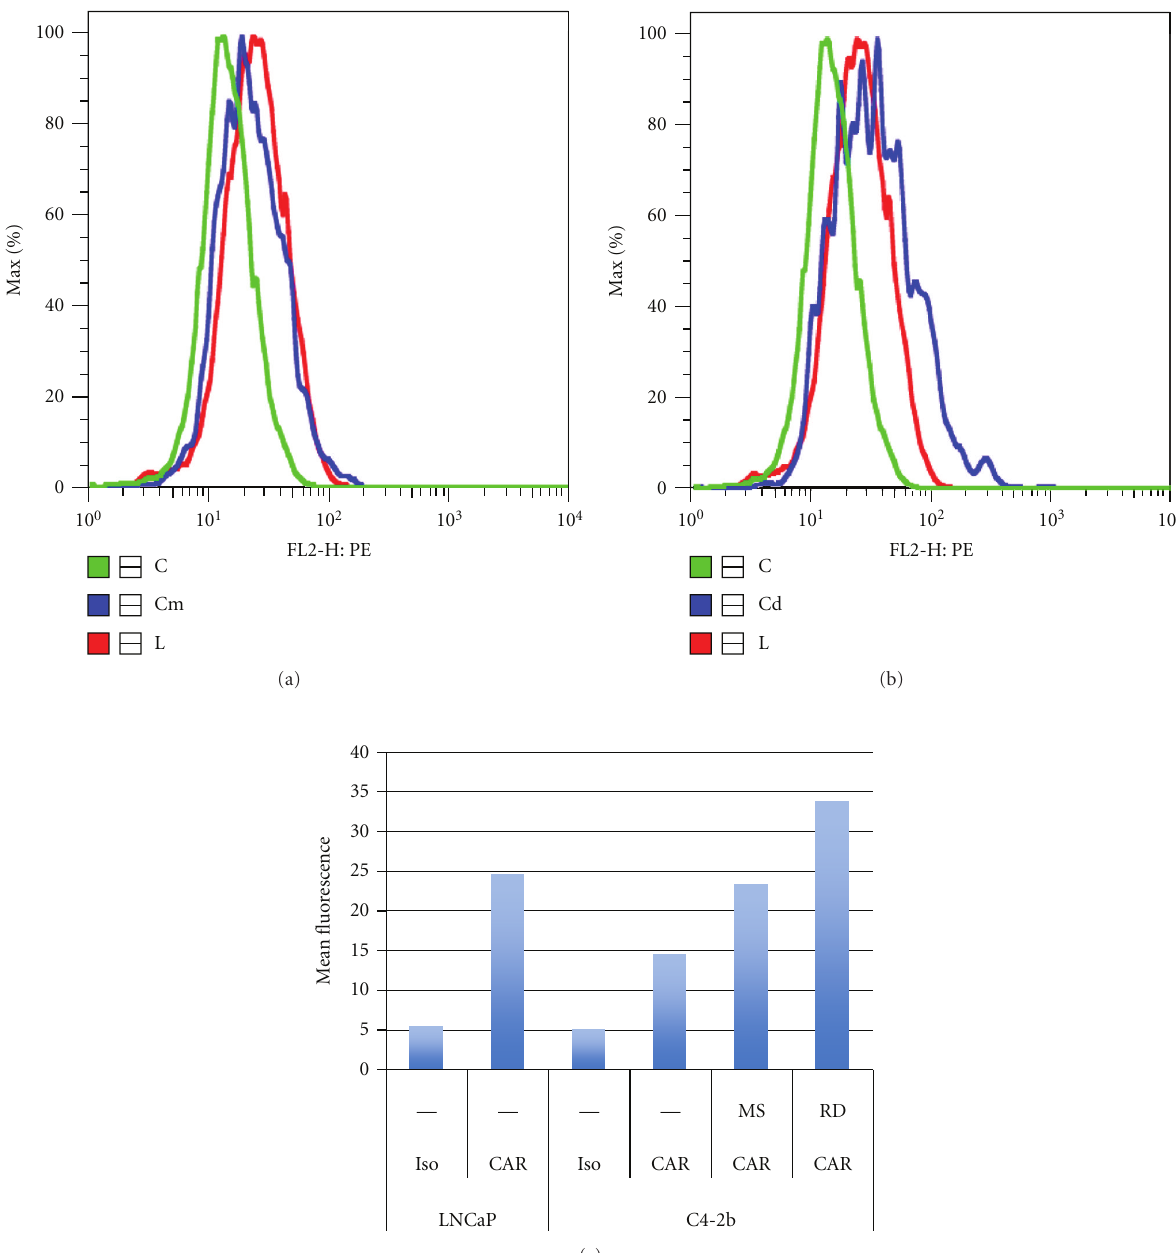
Figure 3: The e ff ect of HDACi on surface CAR expression in C4-2b cells. Surface CAR expression was determined by flow cytometry in LNCaP cells (L = red lines), C4-2b cells (C = green lines), and C4-2b cells in the presence of HDACi (Cd or Cm = blue lines). Cd indicates that 100ng/mL romidepsin was used, whereas Cm indicates a dose of 1 µ M MS-275. (c) Graphical representation of the data. RD =